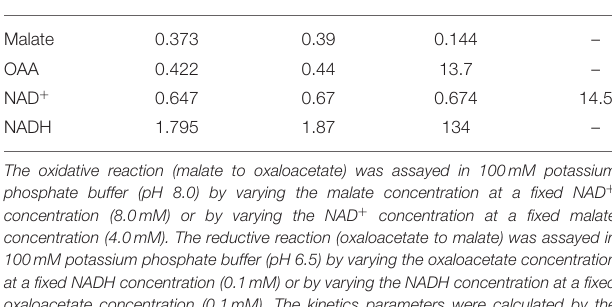
TABLE S1 | Kinetic parameters of Sy MDH calculated by Michaelis-Menten equation. V max k cat k cat / K